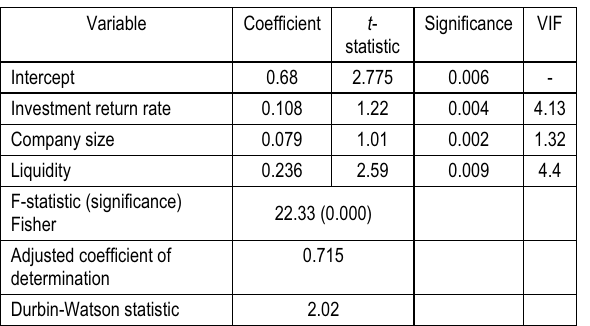
Table 3. Model results